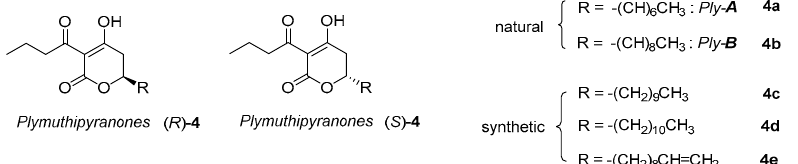
Figure 2. Natural plymuthipyranone A, B ( 4a , 4b ) and synthetic analogues ( 4c – 4e ) containing the 3- acyl-5,6-dihydro-2 H -pyran-2-one structure.